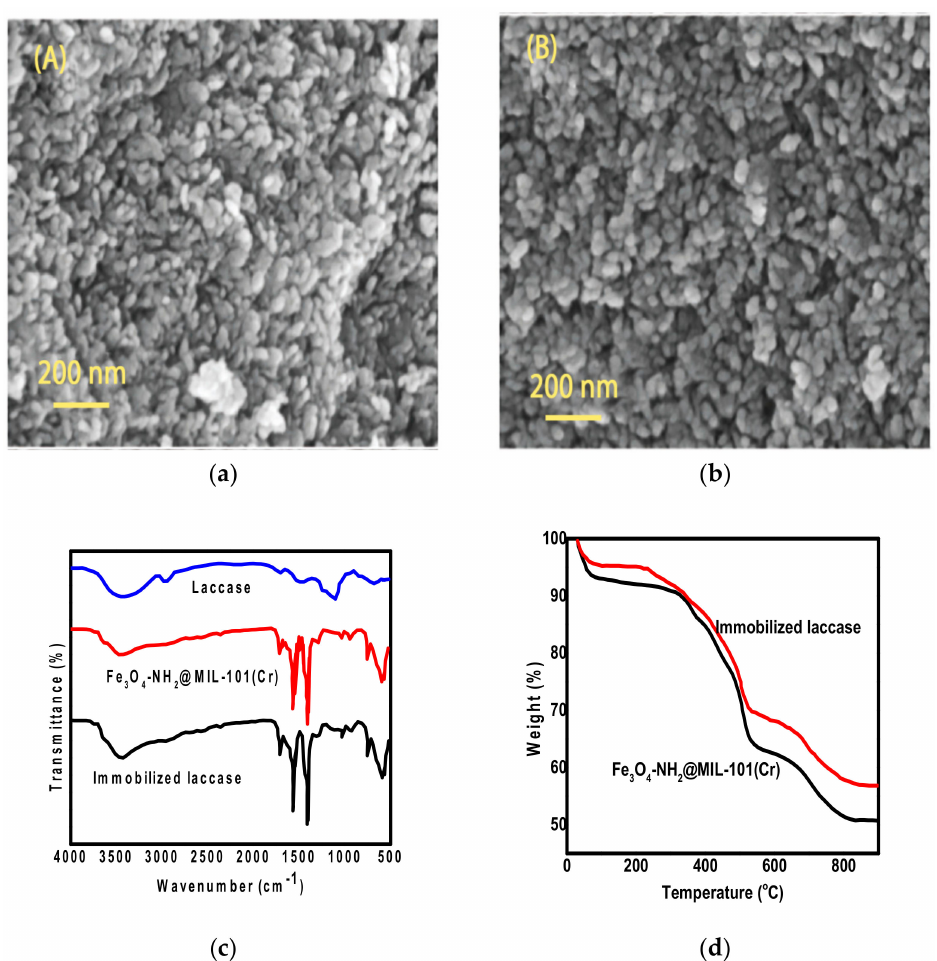
Figure 1c. The Fe 3 O 4 -NH 2 @MIL-101(Cr) MOF typical peaks are represented by sharp peaks at 590, 1400 and 1554 cm − 1 [28]. The amine stretching vibration of the C-N bond is represented by the peak band at 1321 cm − 1 [29]. For the laccase, CH 2 group stretching vibrations in the laccase protein are represented by the peak at 2921 cm − 1 , while the N-H and OH bonds are represented by the band at 3681–3000 cm − 1 [30]. The laccase showed a number of other distinct protein peaks [31,32], like the bands at 1166–949 cm − 1 , 800–500, 1421–1211 cm − 1 and 1643 cm − 1 , corresponding to the protein in the laccase, out-of-plane NH and C-O bending of amide V and VI, CN stretching and NH bending of amide III, and C-O stretching of amide I, respectively.